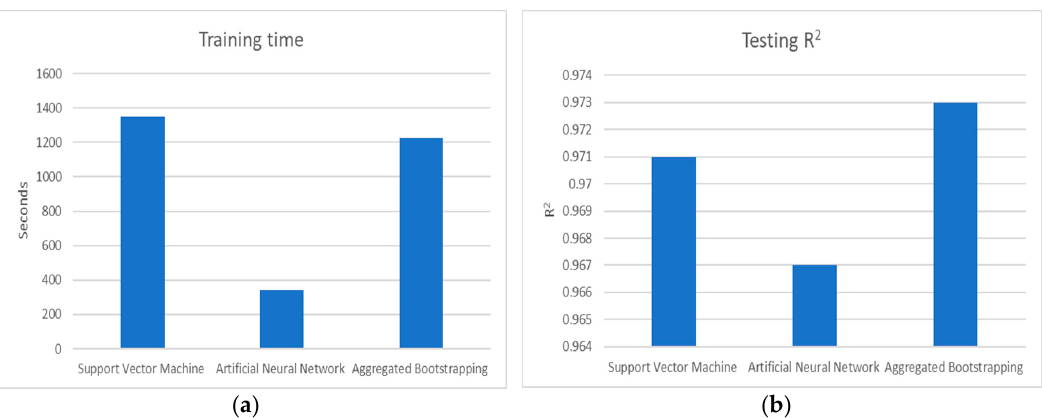
Figure 4. Comparison of Models. ( a ) The training time for the three models in seconds; ( b ) the coefficient of determination (R 2 ) value of the testing period for all the three models.